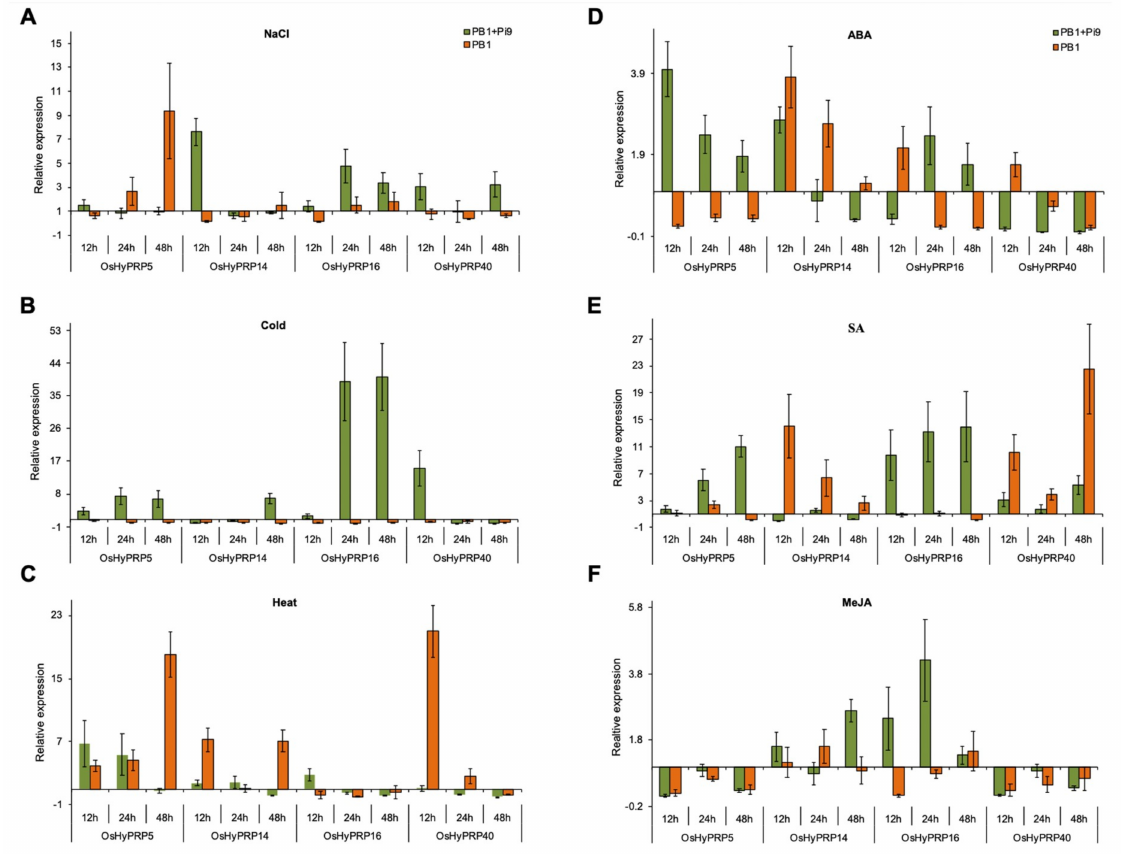
Figure 5. The qRT-PCR based expression of four selected OsHyPPR genes in PB1 and PB1 + Pi9 , in response to stress such as NaCl ( A ), cold ( B ), and heat ( C ), and hormone treatments including ABA ( D ), SA ( E ) and MeJA ( F ). The calculated expression level was relative to the untreated rice seedlings of respective rice lines. The experiment was performed with three technical replicates of three independent biological replicates. The error bars represent the standard error of the means of three independent biological replicates. The rice elongation factor-1A ( OsEF-1a ) gene was used to normalize the qRT-PCR expression